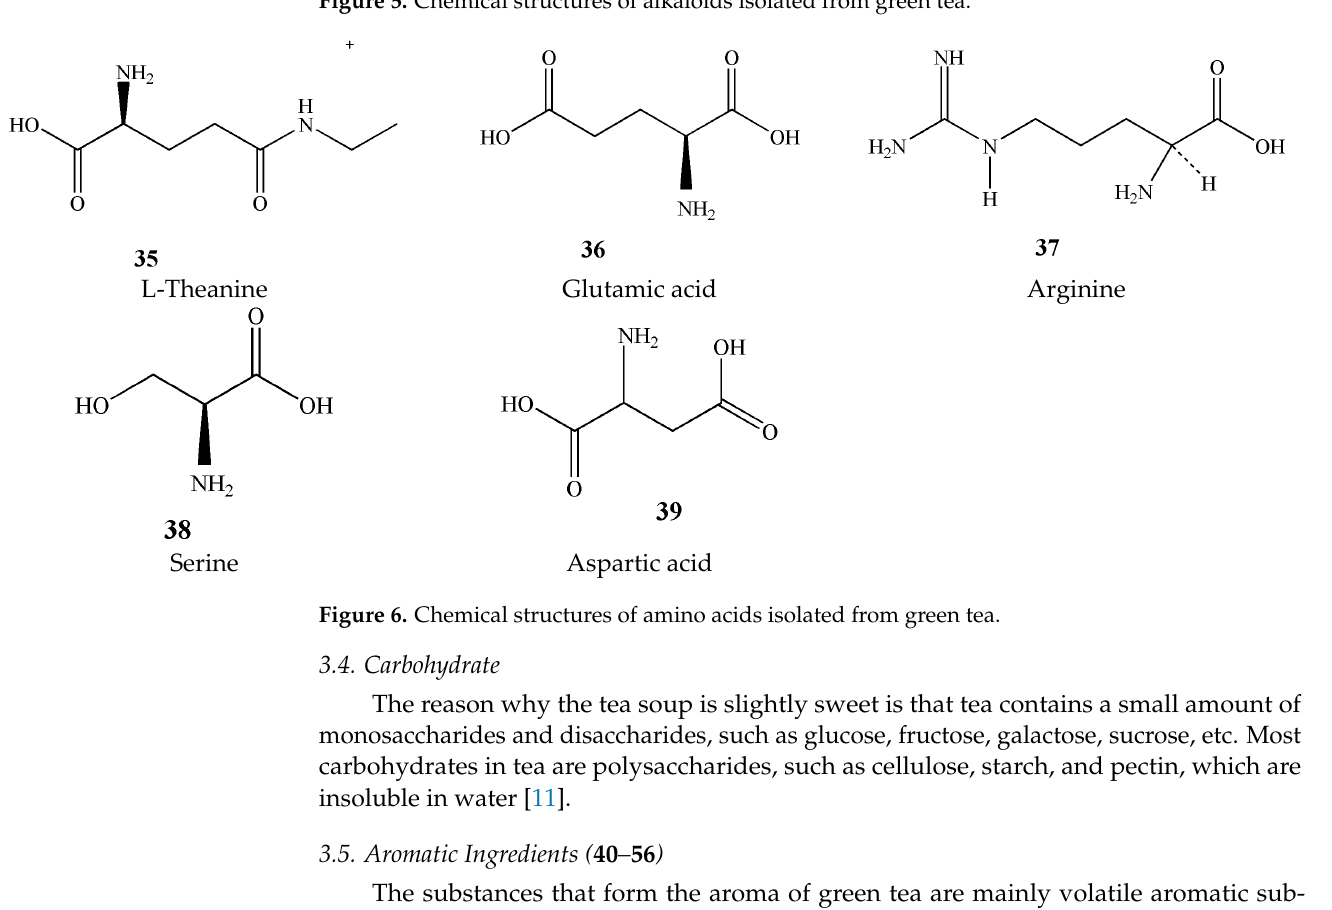
Figure 6. Chemical structures of amino acids isolated from green tea.